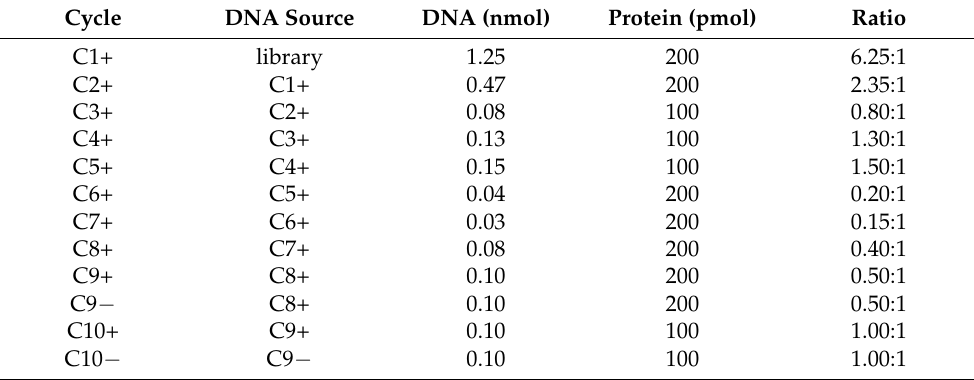
Table 1. Overview of the Hi-Fi SELEX conditions for selection of aptamers to ovarian cancer